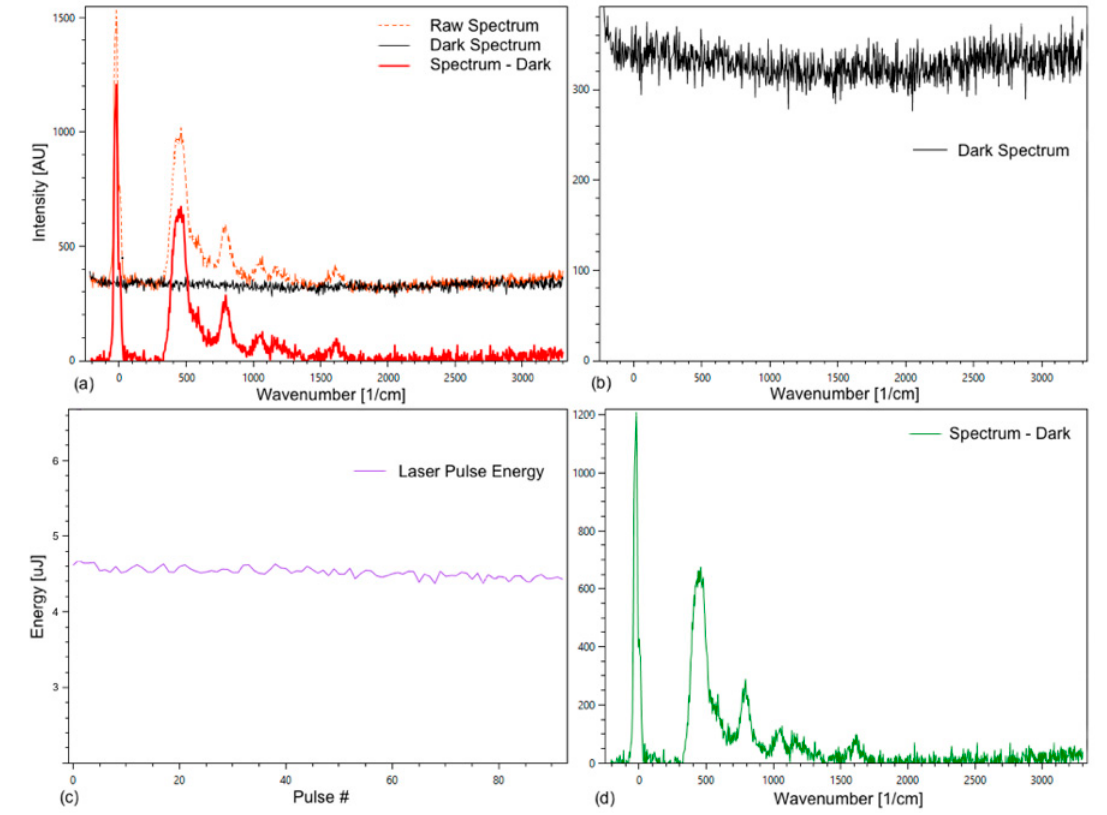
Figure 4. Tab Spectrum Debugger of the Spectrum Analyzer with raw, dark, and substance spectrum of an empty fused silica cuvette ( a ); ( b ) shows the dark spectrum; ( c ) energy plotted against the pulse count; ( d ) substance spectrum. The observed Raman spectrum is from the fused silica of the cuvette, which presumably is out of focus for the spectrometer, but strong enough to be visible.